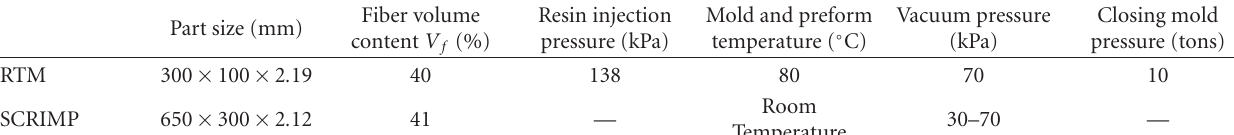
Table 3: SCRIMP and RTM process parameters.